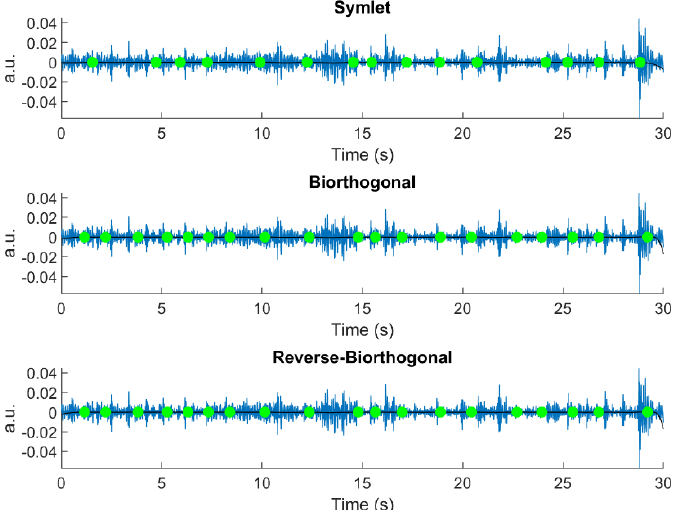
Figure 6. Marking the start of complex pulses from Algorithm #1: Slice and Detect using symlet, biorthogonal, and reverse-biorthogonal mother wavelets. The green dots show the start of each complex pulse. They also serve as the starting point to search for the AO peak in each cardiac cycle. It shows clearly that symlet missed most of the starting points.